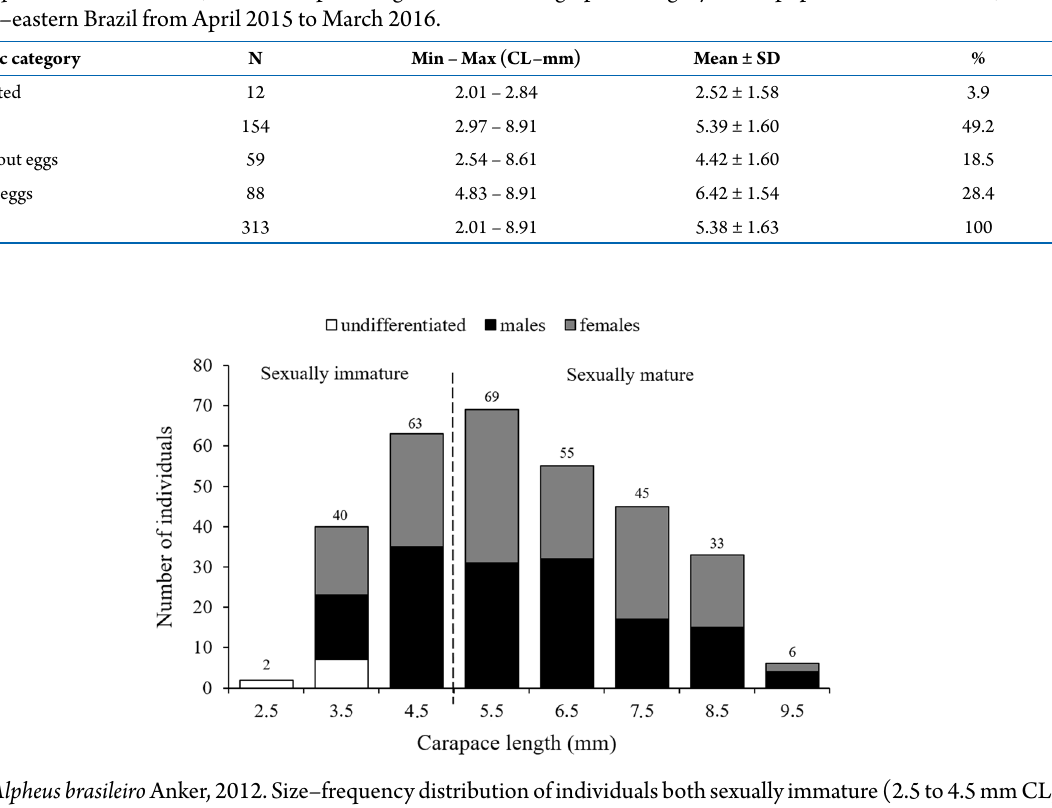
Figure 3. Alpheus brasileiro Anker, 2012. Size–frequency distribution of individuals both sexually immature (2.5 to 4.5 mm CL) and sexually mature (5.5 to 9.5 mm CL). Undifferentiated individuals (white bars), males (black bars) and females (dark grey bars). The values of morphological sexual maturity (4.9 and 4.7 mm CL for males and females respectively) are from the study of population structure and relative growth with the same population (Pescinelli et al. ,